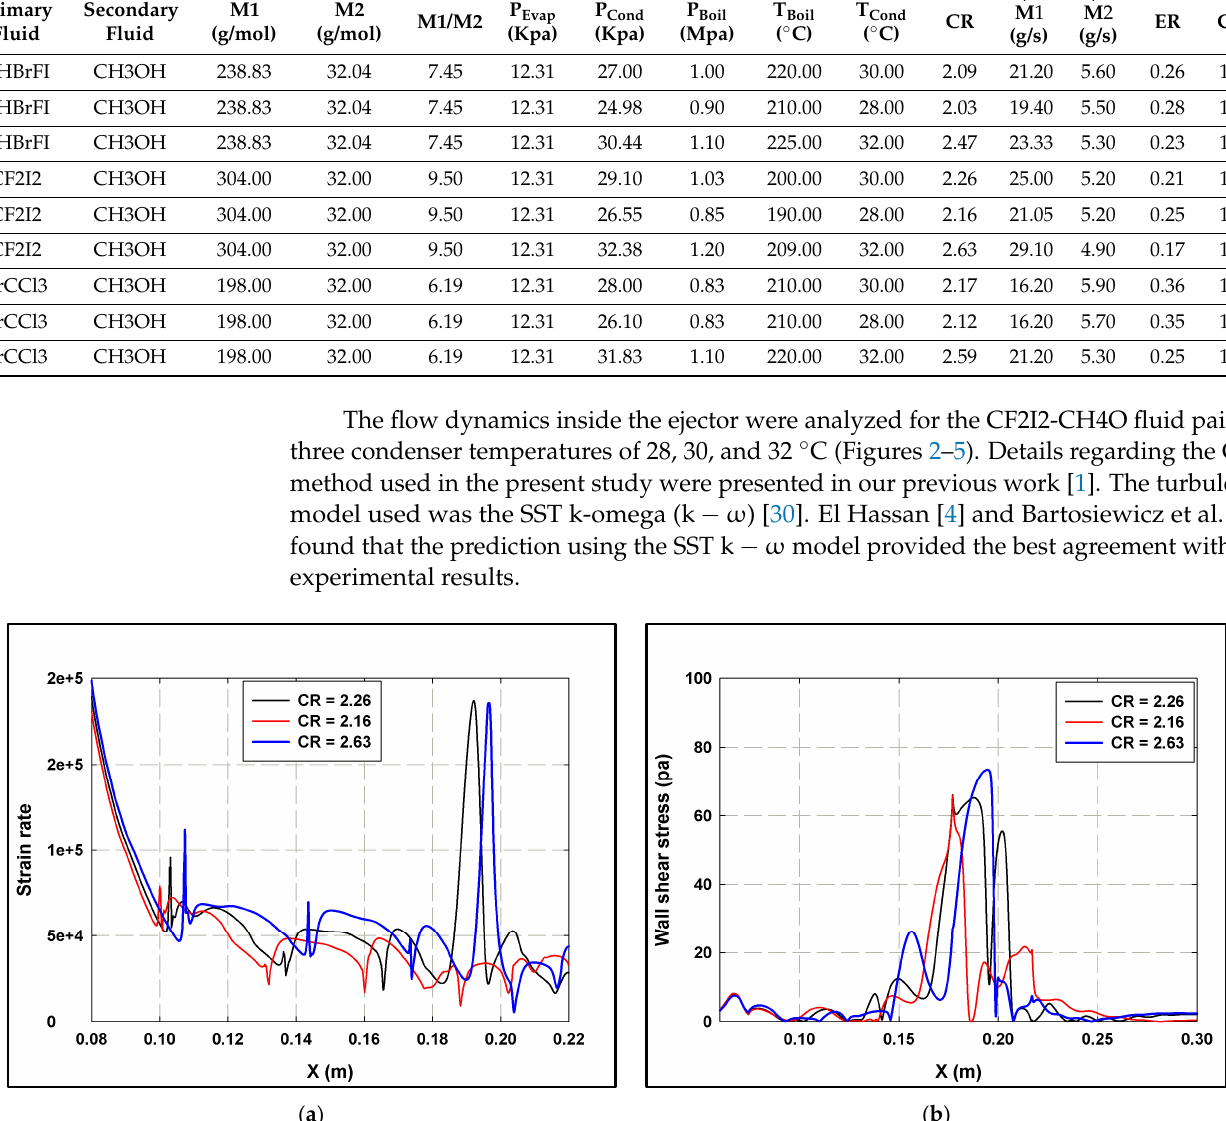
Figure 3. Flow dynamics inside the ejector at a compression ratio of 2.26 for the CF2I2-CH3OH fluid pair.